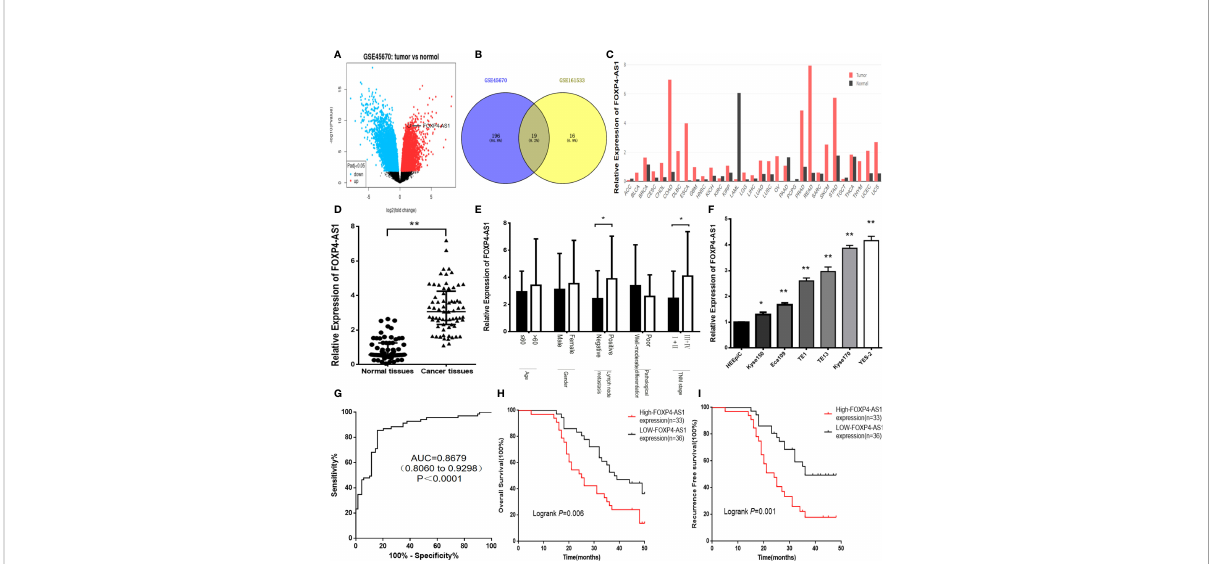
FIGURE 1 FOXP4-AS1 is upregulated in ESCC and correlates with clinicopathological data. (A) The differentially expressed lncRNAs in GSE45670 by the volcano plots (log2|FC|>1). (B) Highly expressed lncRNAs in GSE45670 and GSE161533. (C) FOXP4-AS1 expression in various tumors by GEPIA dataset. (D – F) The expression of FOXP4-AS1 in ESCC tissues, different subgroups and cell lines by qRT – PCR. (G) ROC analysis shows an AUC of 0.8679 for differentiating ESCC from normal tissue. OS (H) and RFS (I) of ESCC patients according to FOXP4-AS1 by Kaplan – Meier analysis. * p < .05 and ** p < .01.